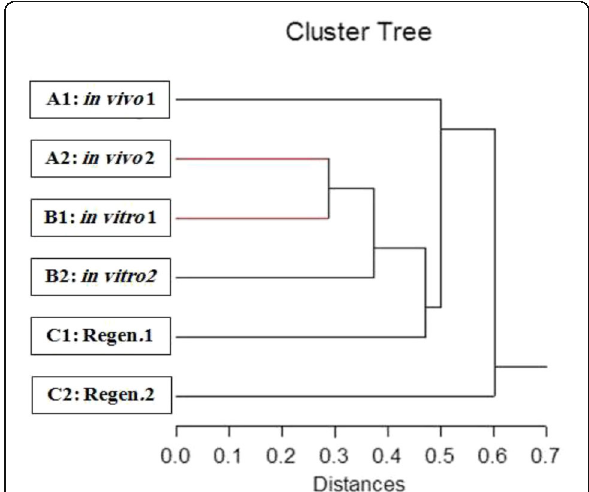
Fig. 4 Dendrogram for six samples of J. curcas plant (2 samples of each of in vivo plants, in vitro plants, and plants regenerated from callus) generated UPGMA cluster analysis of the similarity